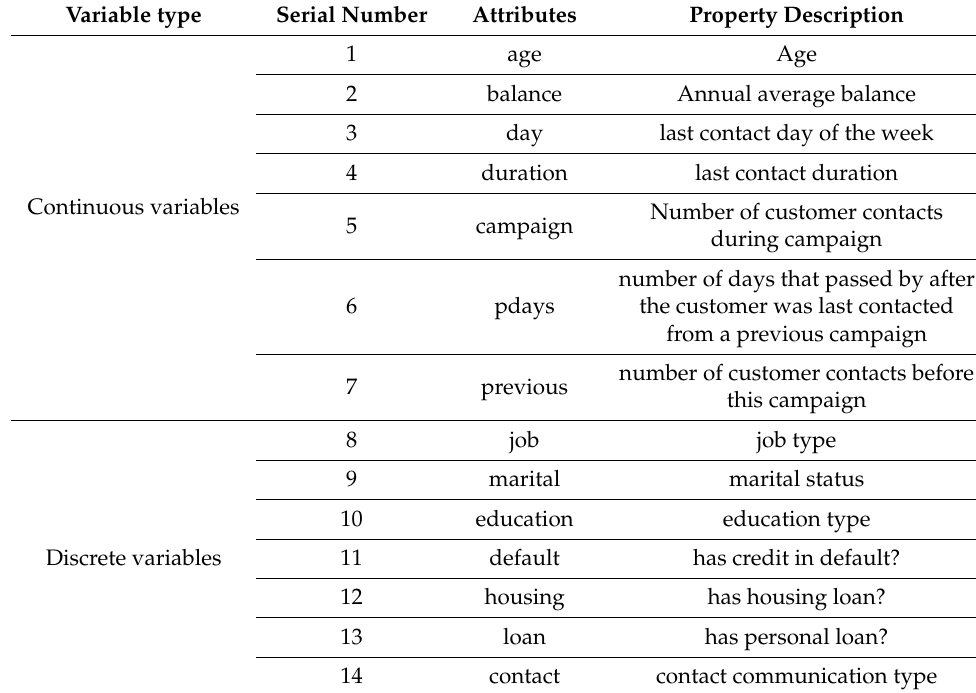
Table 2. Variable description for customer’s personal